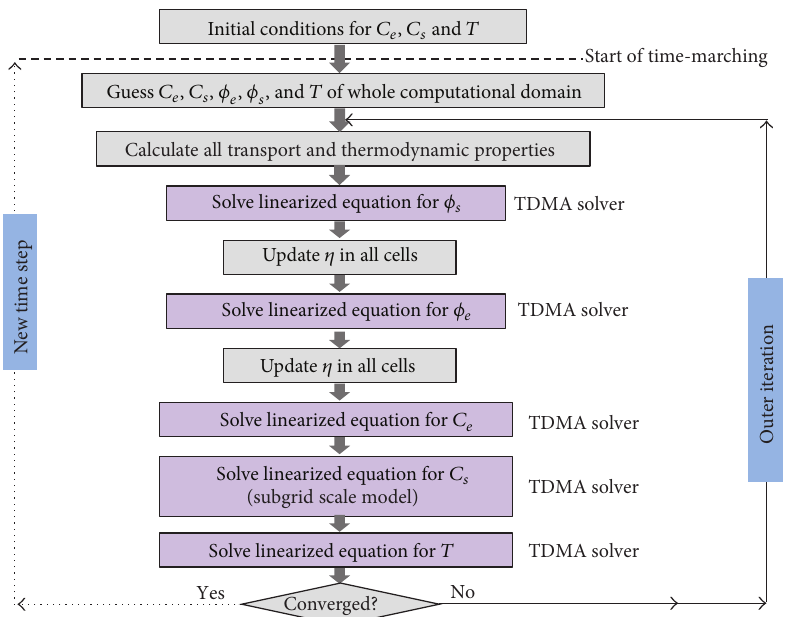
Figure 2: Algorithm employed for solution of the governing